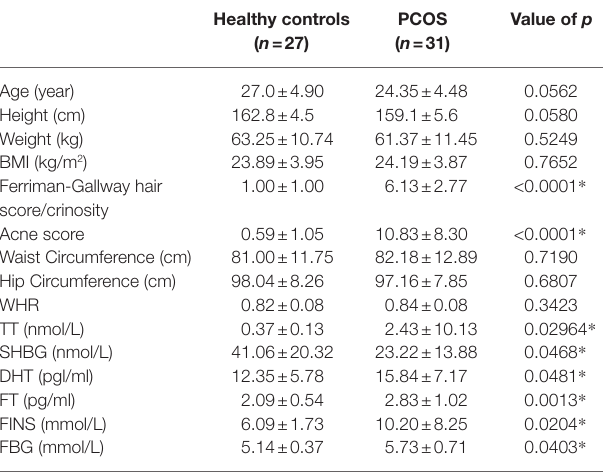
TABLE 1 | Analysis of basic clinical data of PCOS and healthy